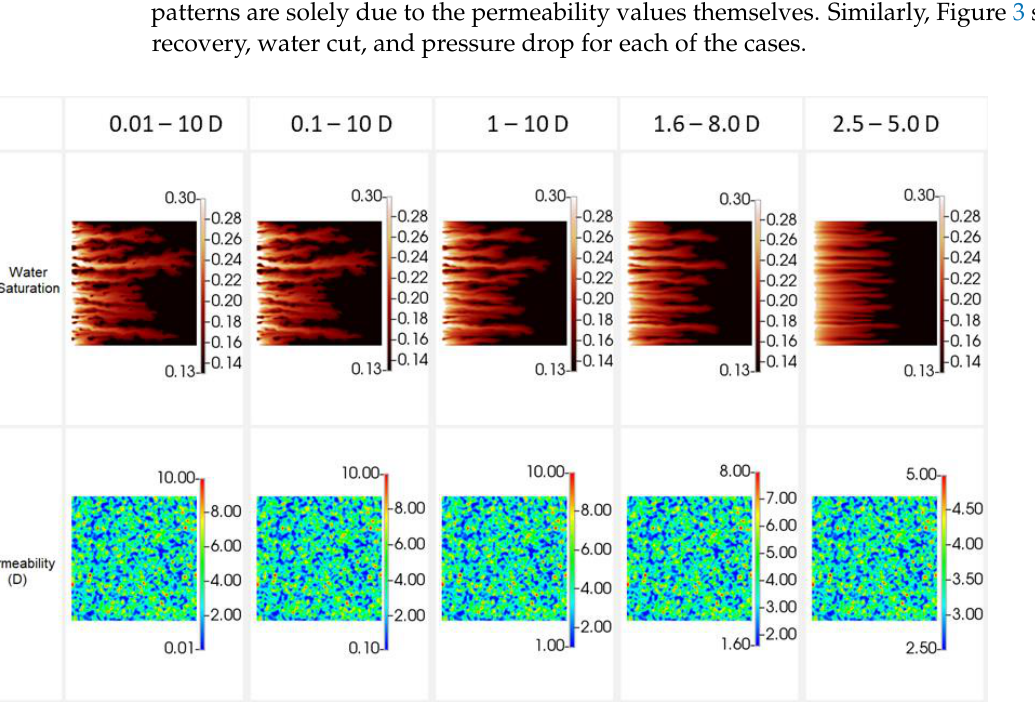
Figure 2. Sensitivity to permeability range for displacement of 2000 mPa.s oil — water saturation ( top ) and permeability ( bottom ).